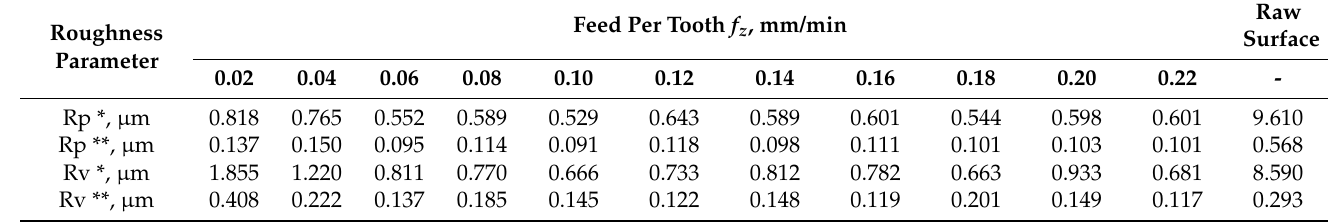
Table 4. Summary of surface roughness parameters of samples machined with variable feed per cutting insert.